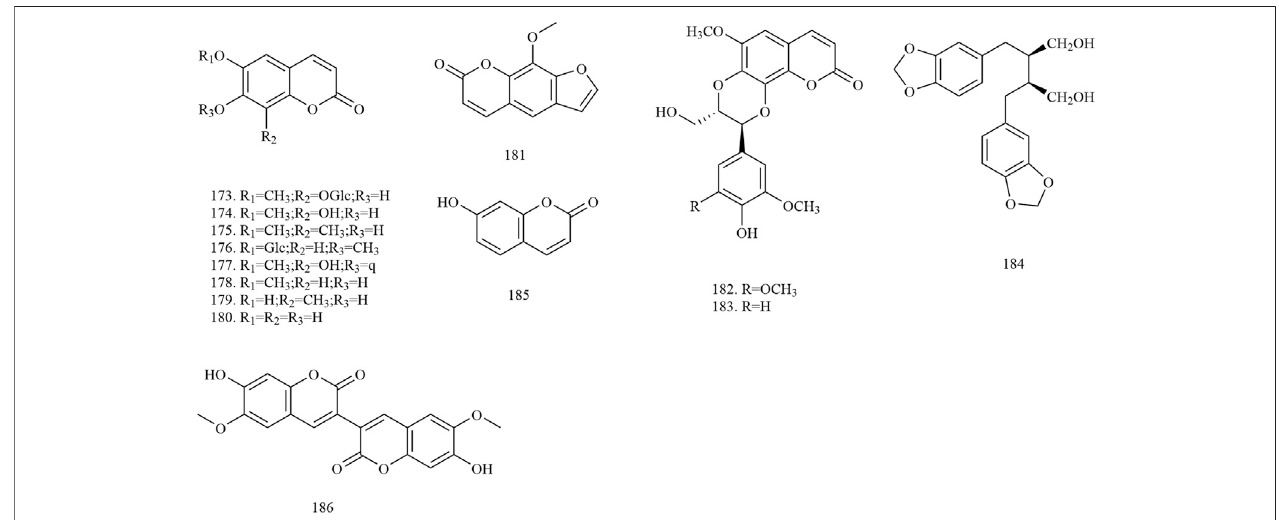
FIGURE 4 | Structures of phenylpropanoids in X. sorbifolium